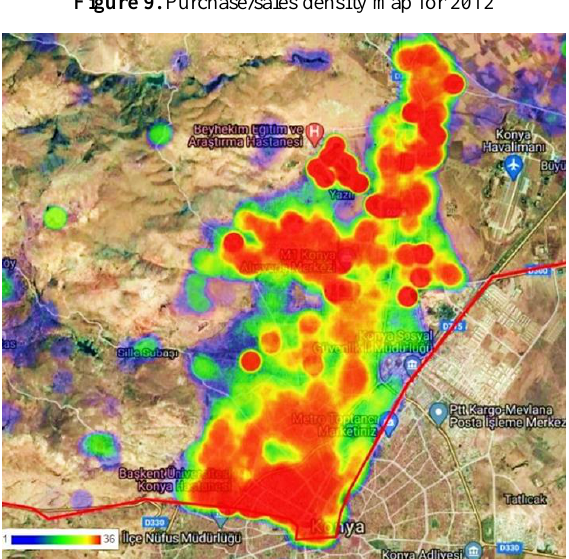
Figure 9. Purchase/sales density map for 2012